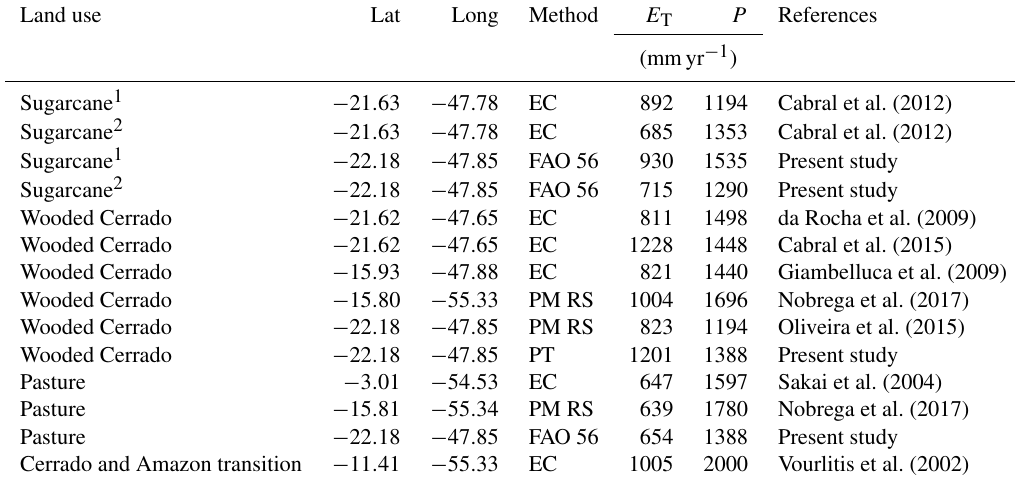
Table 4. Evapotranspiration and rainfall from studies developed in Brazil under similar LCLU to the present study. Land use Lat